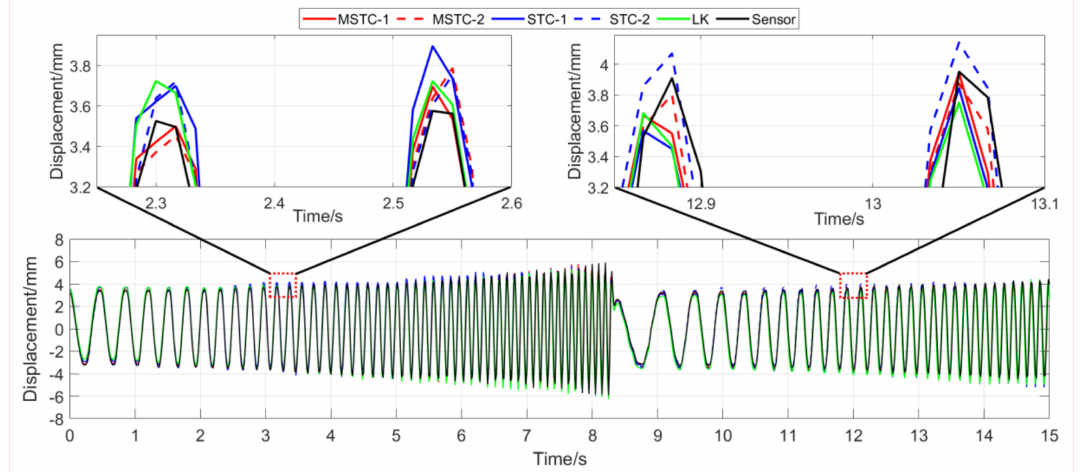
Figure 15. Displacement time history and local amplification in Scenario I (60 FPS).